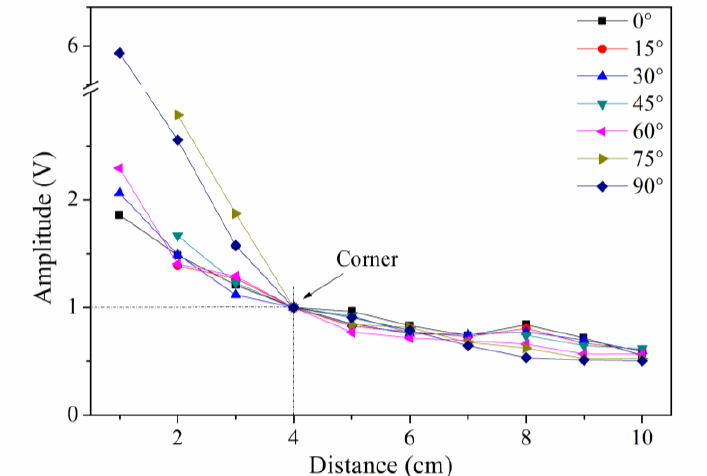
Figure 4. Amplitudes of detected waveforms at different distances for different angles after normalizing the detected waveforms’ amplitudes to 4